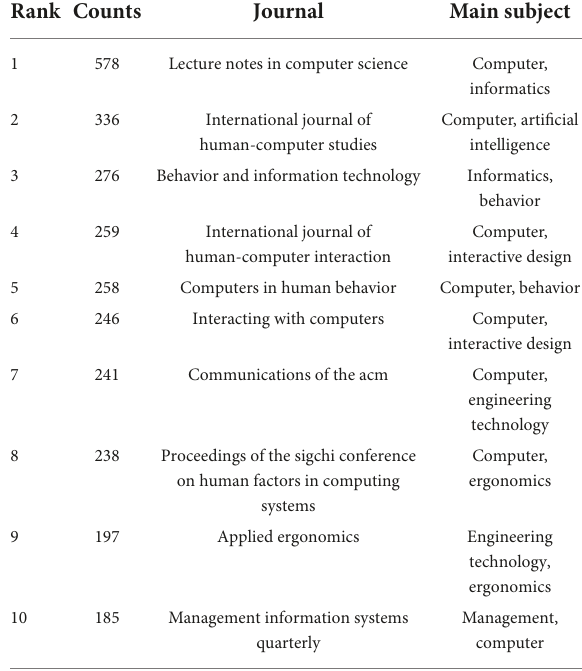
TABLE 2 Co-citation analysis of top 10 core